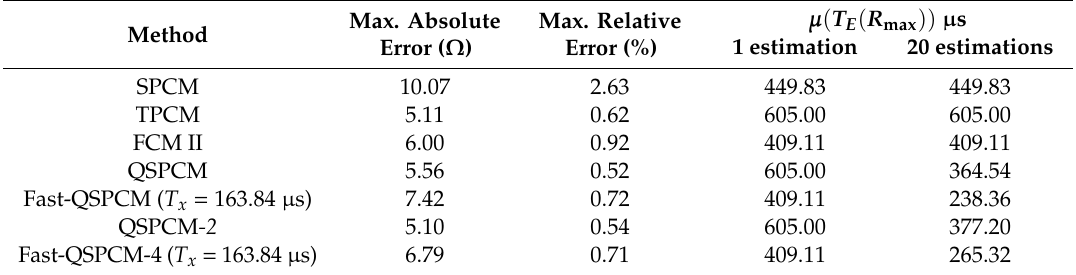
Table 2. Comparison of the performance of the di ff erent methods for a range of resistors with values between 267.56 Ω and 7464.5 Ω